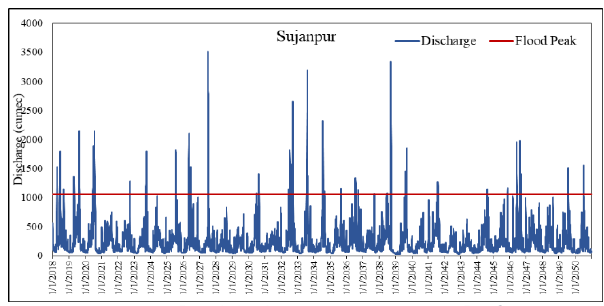
Figure 24 Simulated discharge at Sujanpur outlet for near future period